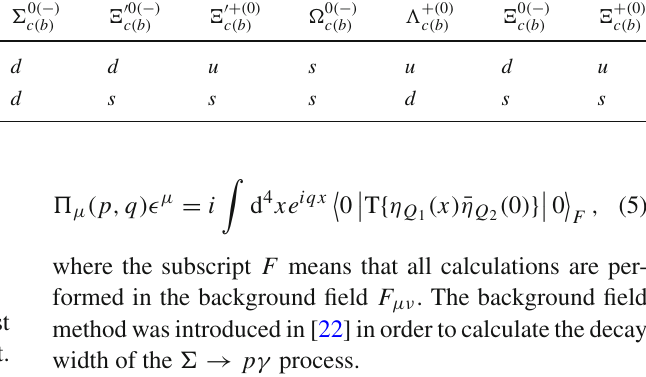
Table 1 Light quark contents of the heavy baryons belonging